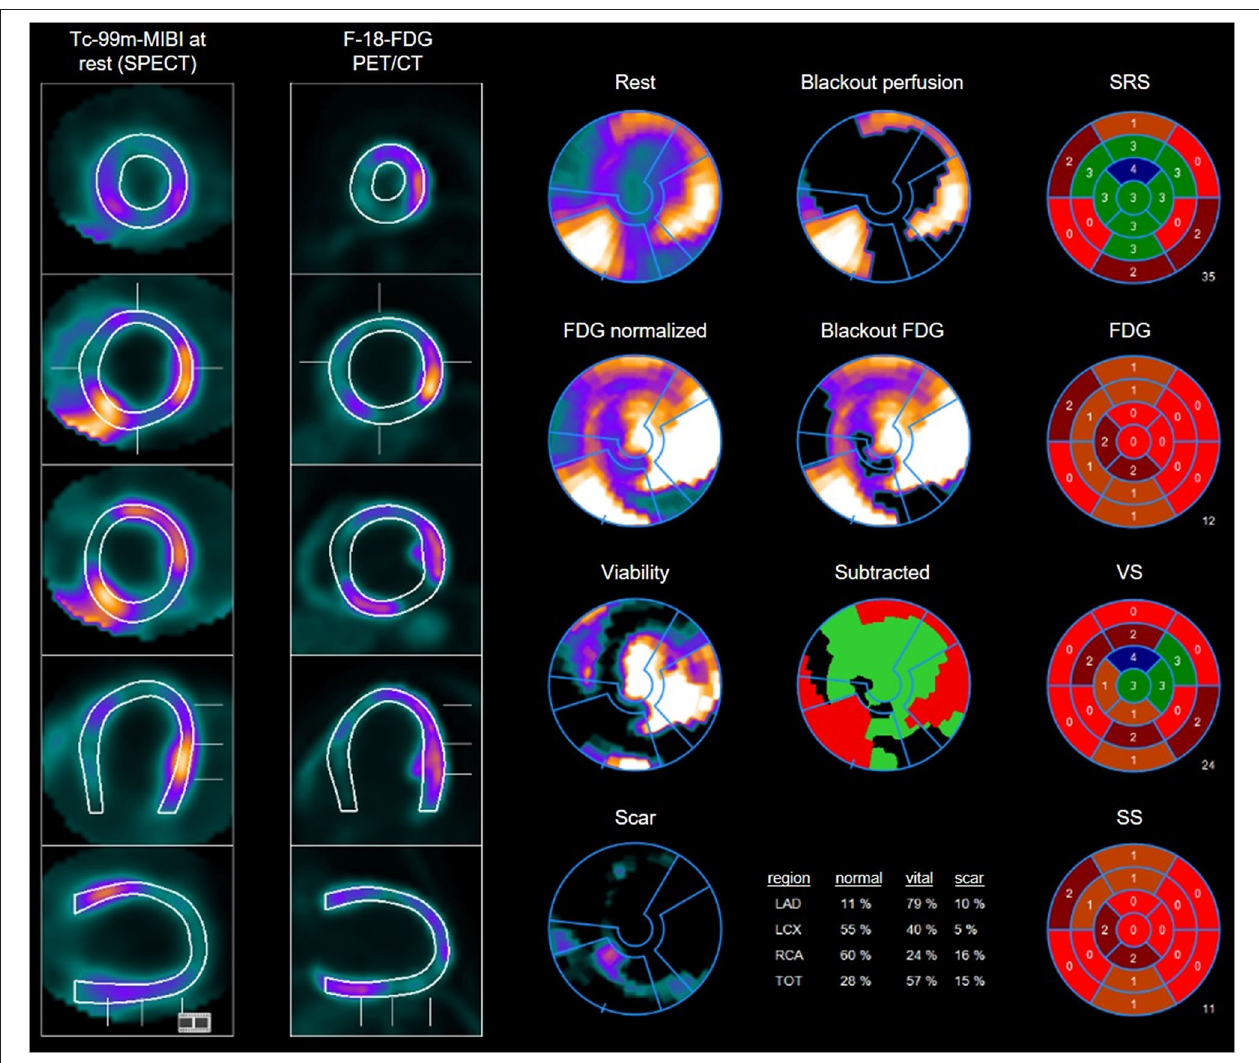
FIGURE 2 | Example of multiple perfusion defect with hibernating myocardium as well as areas of scars: 45 years old male with perfusion defects in the anteroseptal wall as well as on the anterolateral and posterolateral wall in the Tc-99m-MIBI rest scan. FDG uptake in the viability F-18-FDG-PET/CT scan shows some uptake in the areas with perfusion defects resulting in the diagnosis of hibernating myocardium but also some areas with no FDG uptake especially septal and posterior resulting in the diagnosis of scars. Overview and polar maps with SRS, summed rest score; VS, vitality score; SS, scar